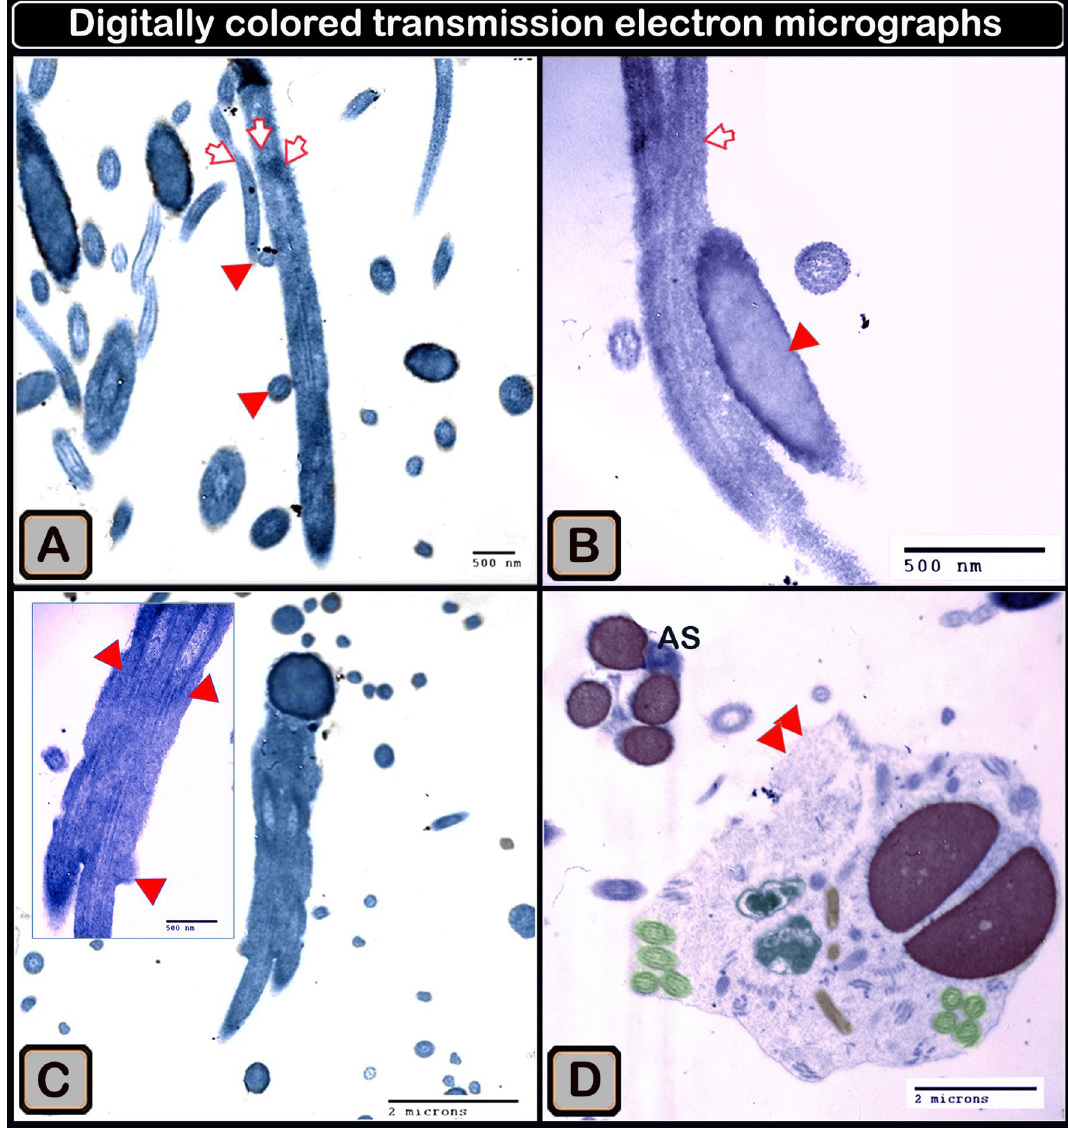
Figure 6. Various micrographs displaying sperm head and wrapped tail aggregation using various methods. ( A ) Digitally colored transmission electron micrograph of a sperm bundle in a cut section show twisted sperm heads having two portions of the nucleus (blue color) and several potions of the flagellum (green color). ( B ) Digitally colored scanning electron micrograph showing a cluster of sperm medusa-like heads that appeared to be coated (arrows). ( C ) Semithin sections showing sperm head aggregation (arrows) and wrapped tails (arrowheads). ( D ) Acridine orange-stained sperm smear micrograph shows aggregates of sperm heads (arrows) and wrapped adherent tails (arrowheads). Note that the adhesive substance (S) covered the sperm head. Magnification of ( D )